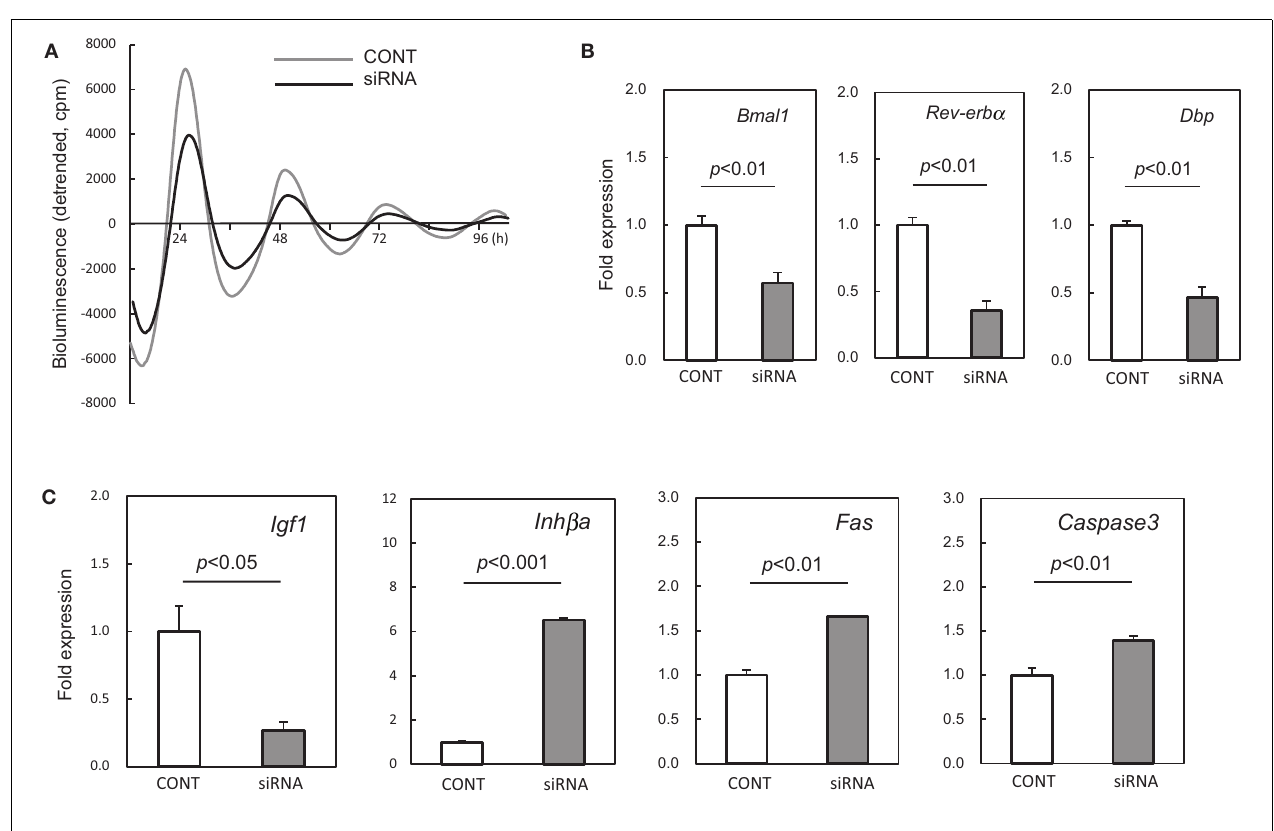
0h), and then monitored Per2-dLuc oscillations. (B) RNA samples were collected 39h after synchronization, and RT-qPCR analyses of transcript levels were performed using their specific primers. (C) Transcript levels of Igf1 , Inh β a , Fas , and Caspase3 were measured in the UESCs treated with siRNA or no silencing RNA. Each value represents the means ± SEM ( n =